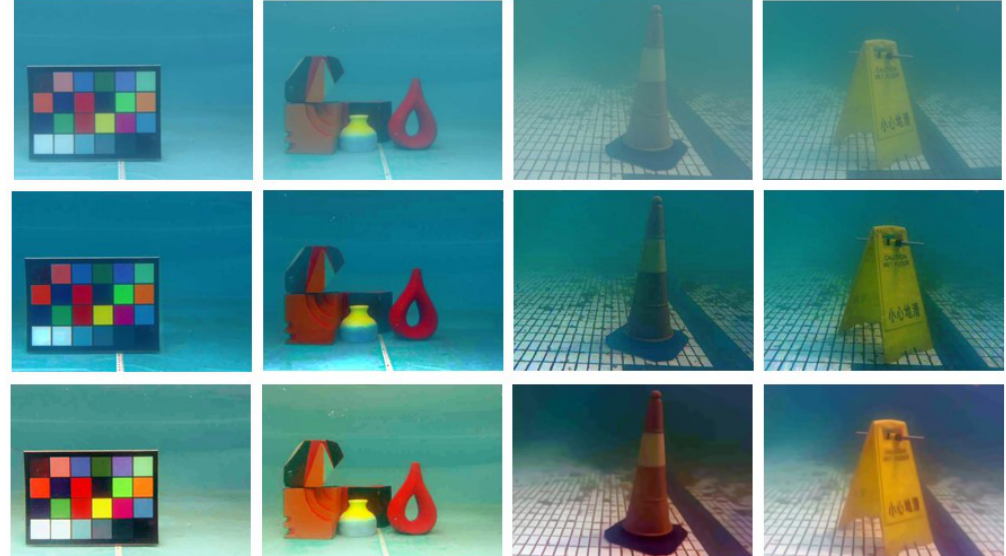
Figure 5. Comparison of the original underwater images, the results using the method in Reference [38] and the results using BM3D filtering and color correction, where the first row shows the original underwater images, the second row shows the results using the method in Reference [38] and the third row shows the results using BM3D filtering and color correction.